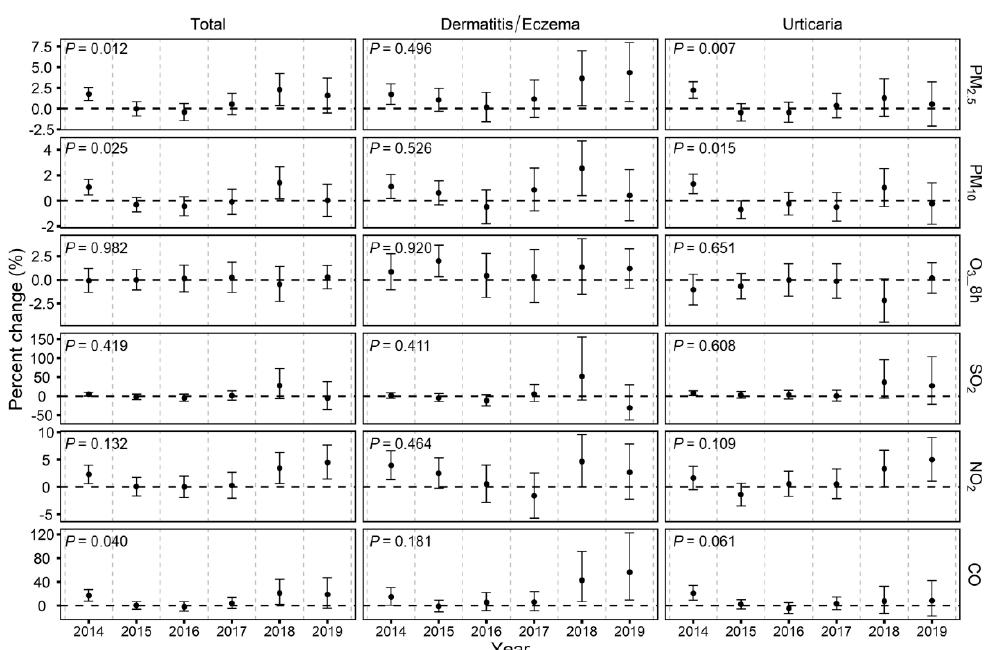
Figure 4. Annual percent changes and 95% confidence intervals (CIs) in daily emergency room visits for skin diseases along with a 10 μ g/m 3 increase in in PM 2 . 5 (lag 0–5), PM 10 (lag 0–3), 8 h maximum O 3 (lag 0–5), SO 2 (lag 0–6), NO 2 (lag 0–1) and a 1 mg/m 3 increase in CO (lag 0–5) from 2014–2019. Note: p -value indicates the results of the heterogeneity test on annual estimates based on multiplicative interaction terms of pollutants and year.